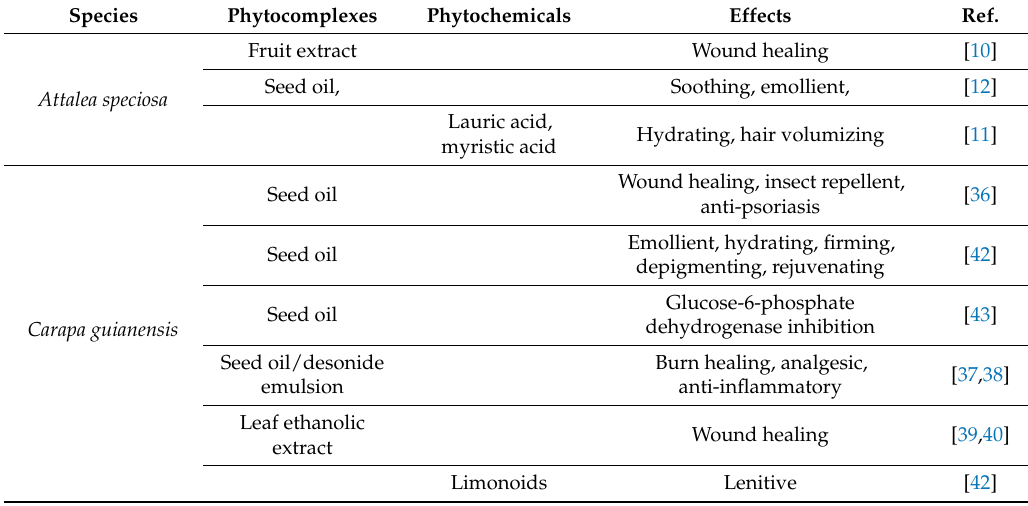
Reported Effects on Skin and Hair of Phytocomplexes and Active Principles from Amazonian